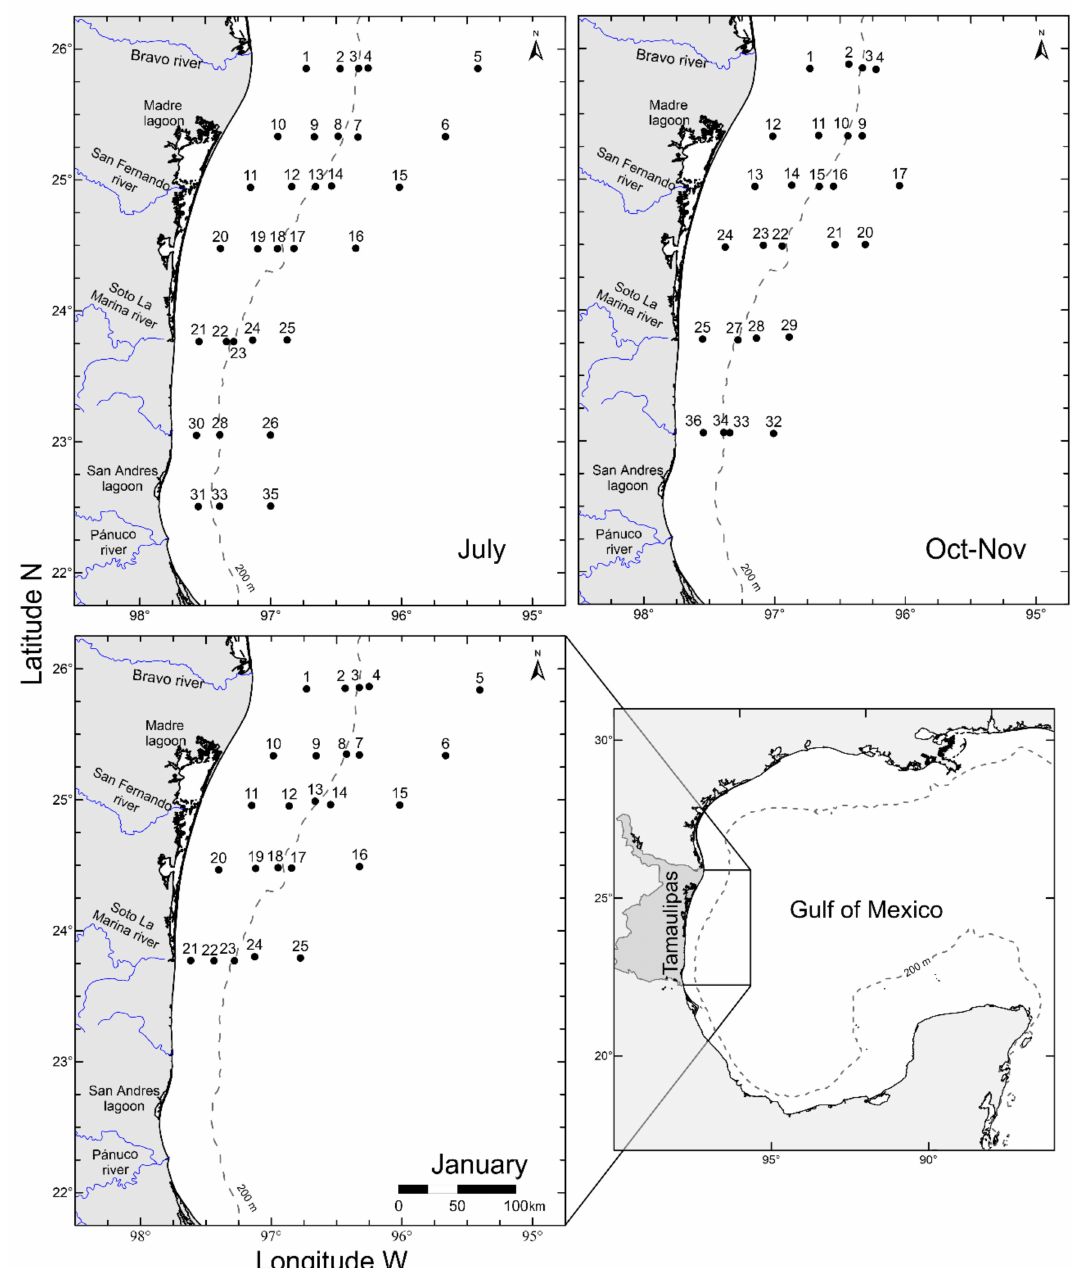
Figure 1. Study area and location of sampling stations during the three sampling